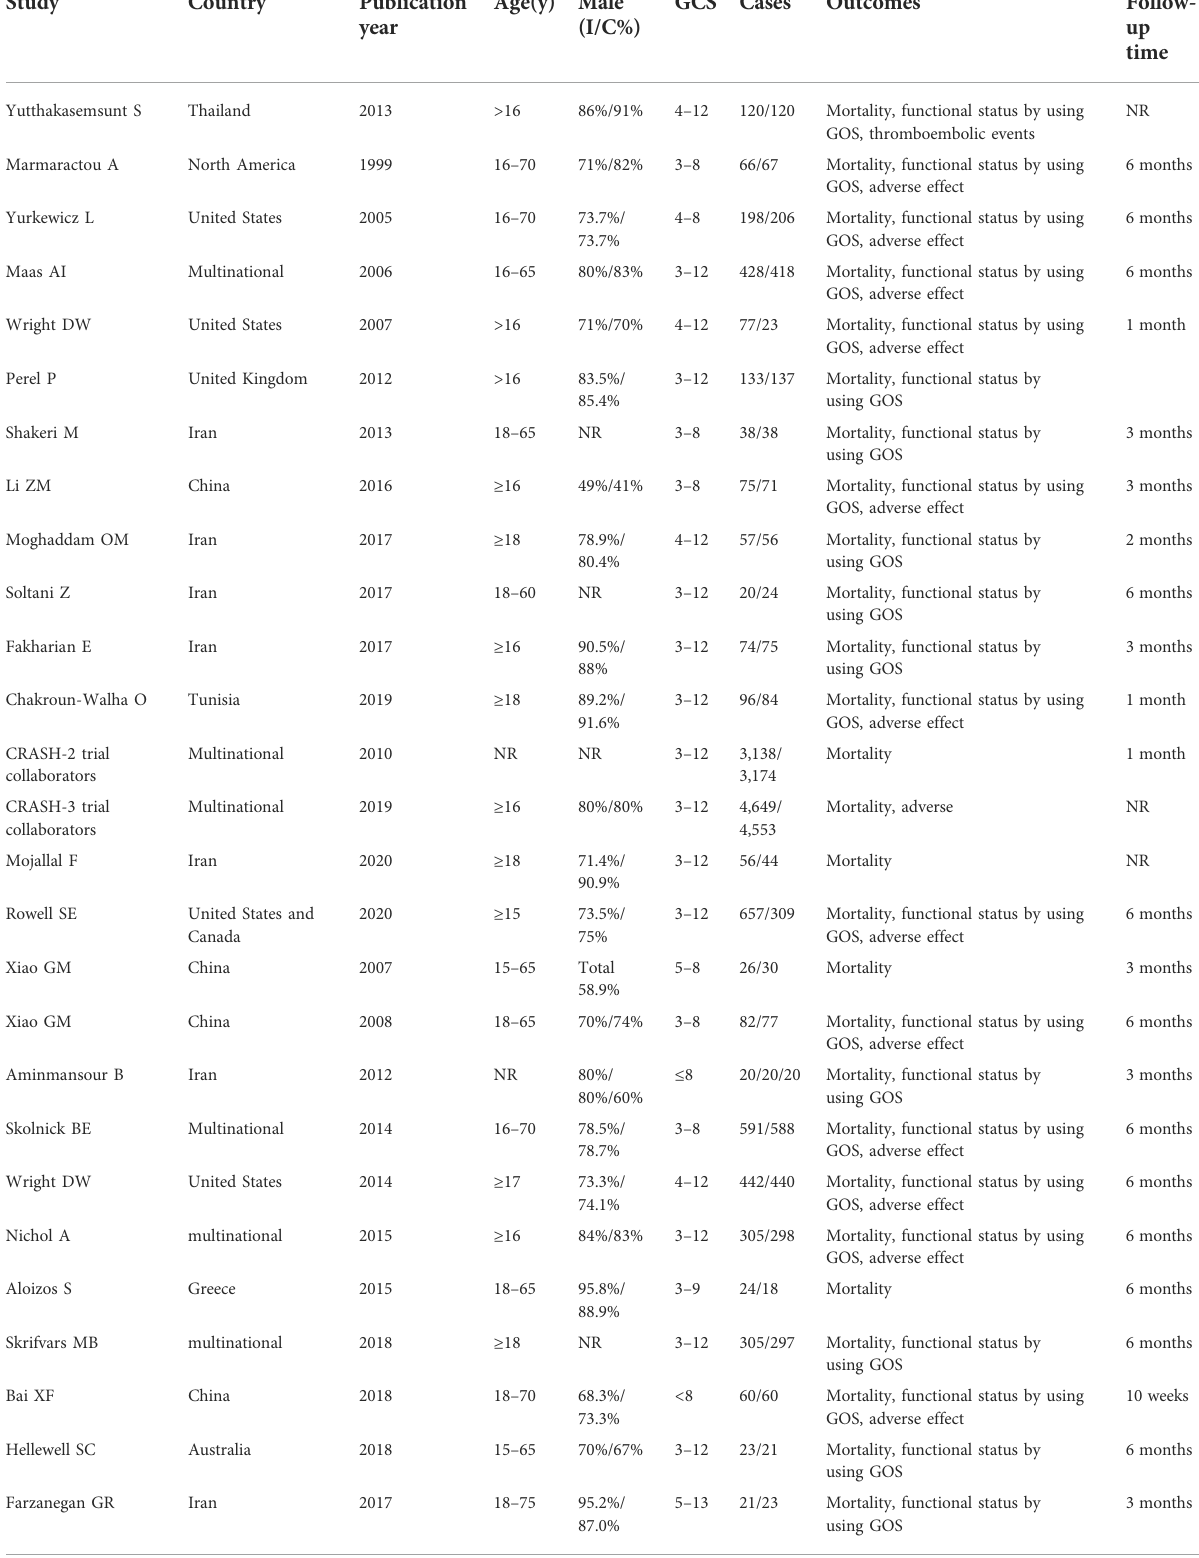
TABLE 1 Baseline characteristics of involved